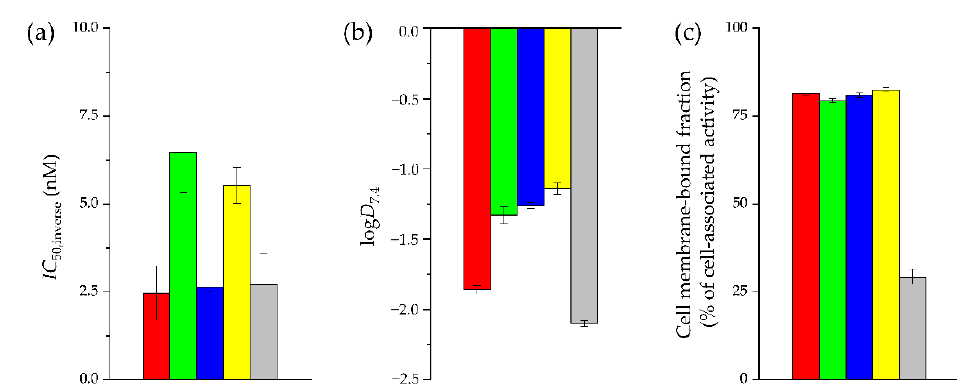
Figure 2. In vitro data of [ 99m Tc]Tc-N 4 -asp-MJ9 (red), [ 99m Tc]Tc-N 4 -asp-[Bta 8 ]MJ9 (green), [ 99m Tc]Tc- N 4 -[Hse 7 ]MJ9 (blue), [ 99m Tc]Tc-N 4 -[ α -Me-Trp 8 ]MJ9 (yellow) and [ 99m Tc]Tc-Demobesin 4 (grey): ( a ) Affinity of 99m Tc-labeled ligands (8.0 nM/well) on PC-3 cells (1.5 × 10 5 cells/mL/well) using 3-I-tyr 6 -